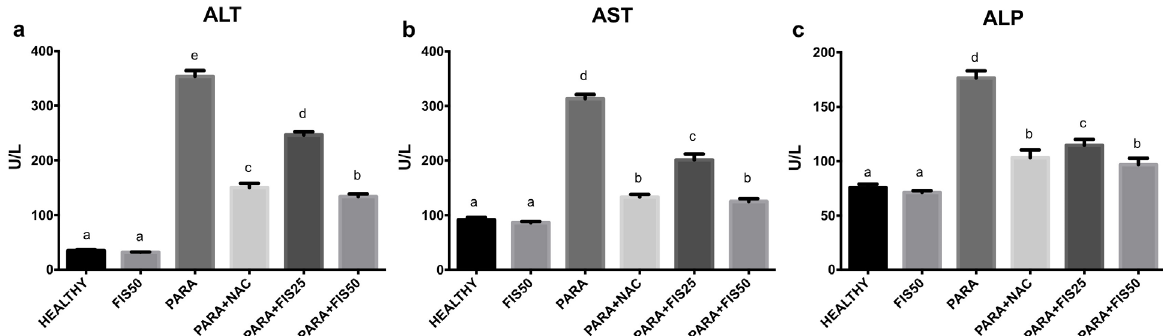
Figure 1. The Results of Serum ALT, AST and ALP Levels. a: ALT, b: AST, c: ALP. Means with the same letter are not significantly different; means with different letters indicate significant differences between the groups according to the Duncan test (p < 0.05). Results are means ±